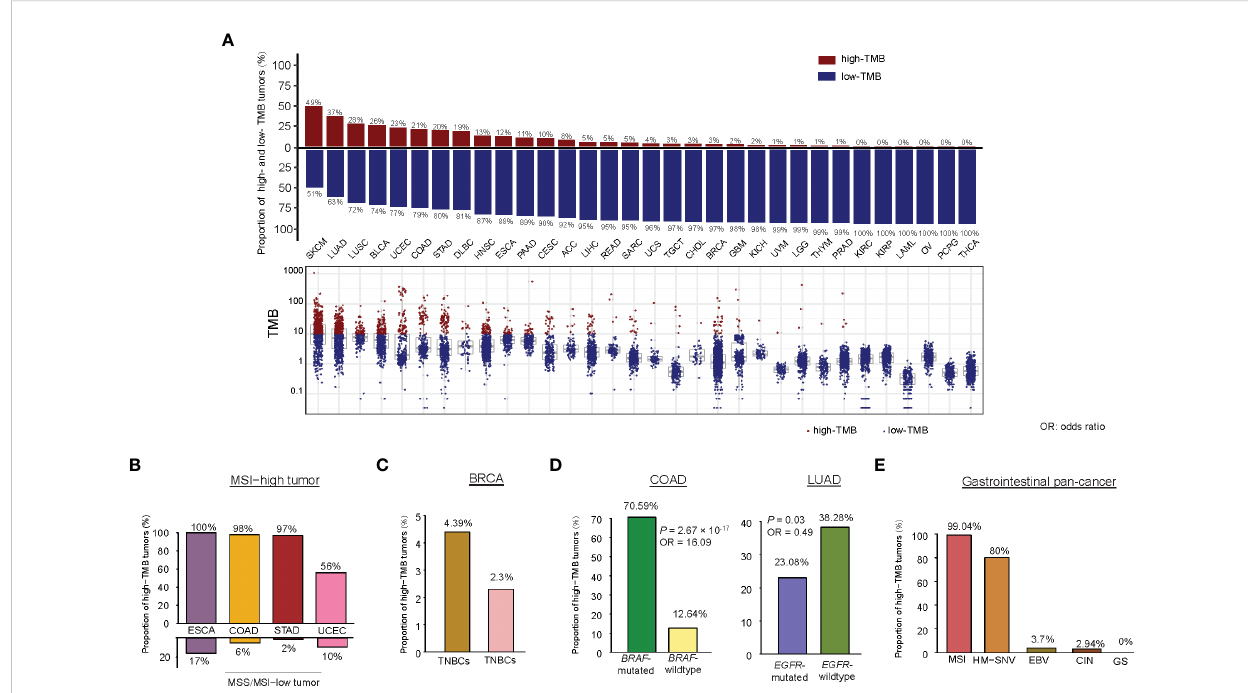
FIGURE 1 Comparison of TMB between different cancer types or subtypes. (A) The TMB distribution in each cancer type. Percentages of high-TMB cancers in each cancer type are shown. Proportions of high-TMB tumors in MSI-high versus MSS/MSI-low cancers (B) , in TNBC versus non-TNBC (C) , in COAD (or LUAD) with BRAF (or EGFR ) mutations versus without BRAF (or EGFR ) mutations (D) , and in fi ve subtypes of gastrointestinal pan-cancer (E)